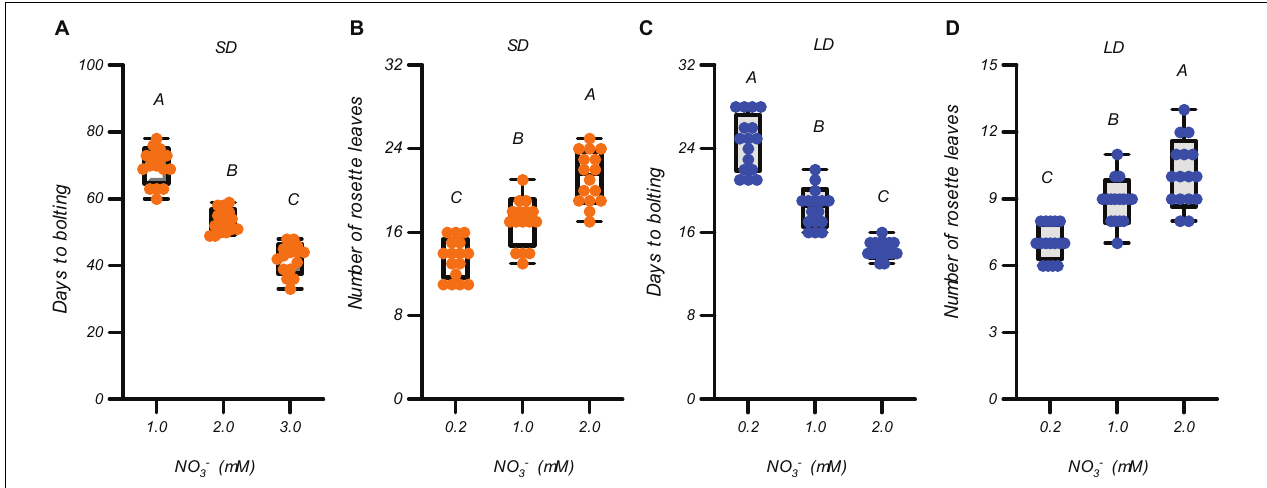
FIGURE 1 | Flowering promotion due to increases in the suboptimal nitrate supply under both LD and SD photoperiods. Days to bolting (A) and number of rosette leaves (B) of Col-0 plants grown under LD conditions (16-h light/8-h dark). Days to bolting (C) and number of rosette leaves (D) of Col-0 plants grown under SD conditions (8-h light/16-h dark). Seedlings were planted in media containing 0.2, 1, or 2 mM nitrate. The potassium concentrations in all growth media were adjusted to 2 mM using K 2 SO 4 . At least 20 plants grown in each of the LD and SD conditions were used to determine the bolting time and number of rosette leaves. Error bars represent ± standard deviations. Different letters indicate significant differences between means, as determined using a one-way ANOVA followed by Tukey’s multiple comparisons test ( P < 0.05).